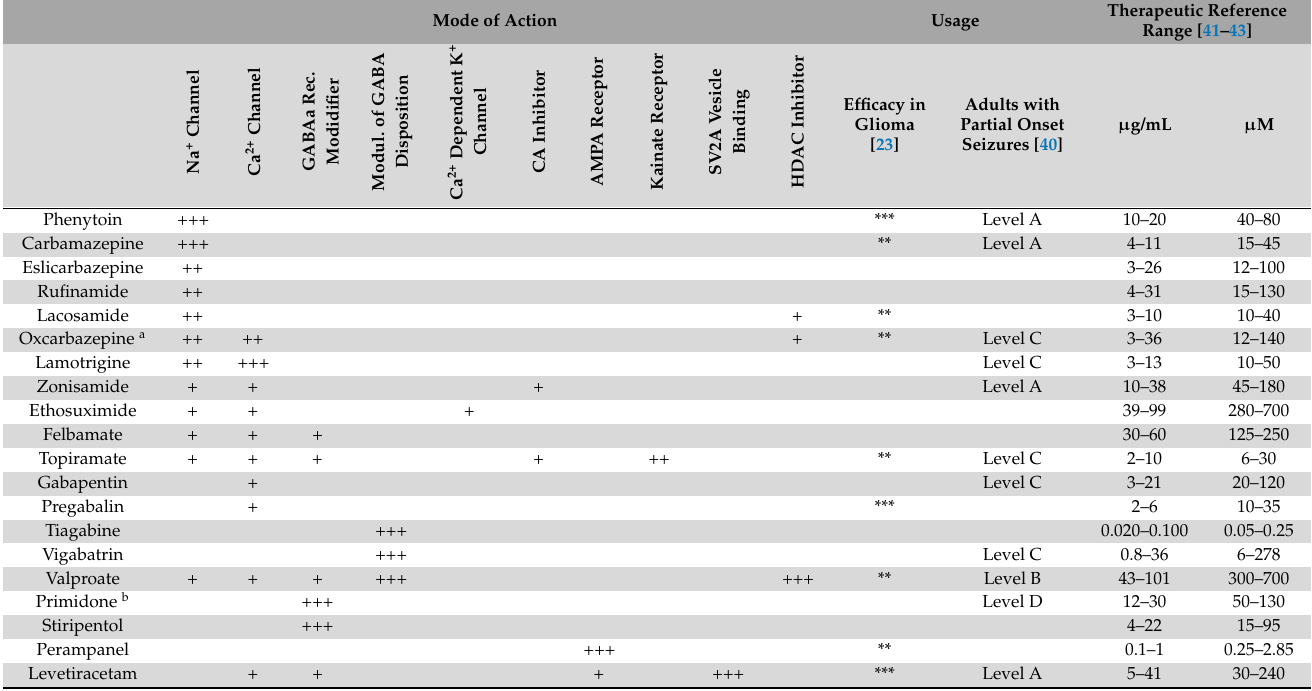
Table 2. Mode of action, usage, and therapeutic reference range of antiepileptic drugs [23,40–43]. Mode of Action Usage Therapeutic Reference Range